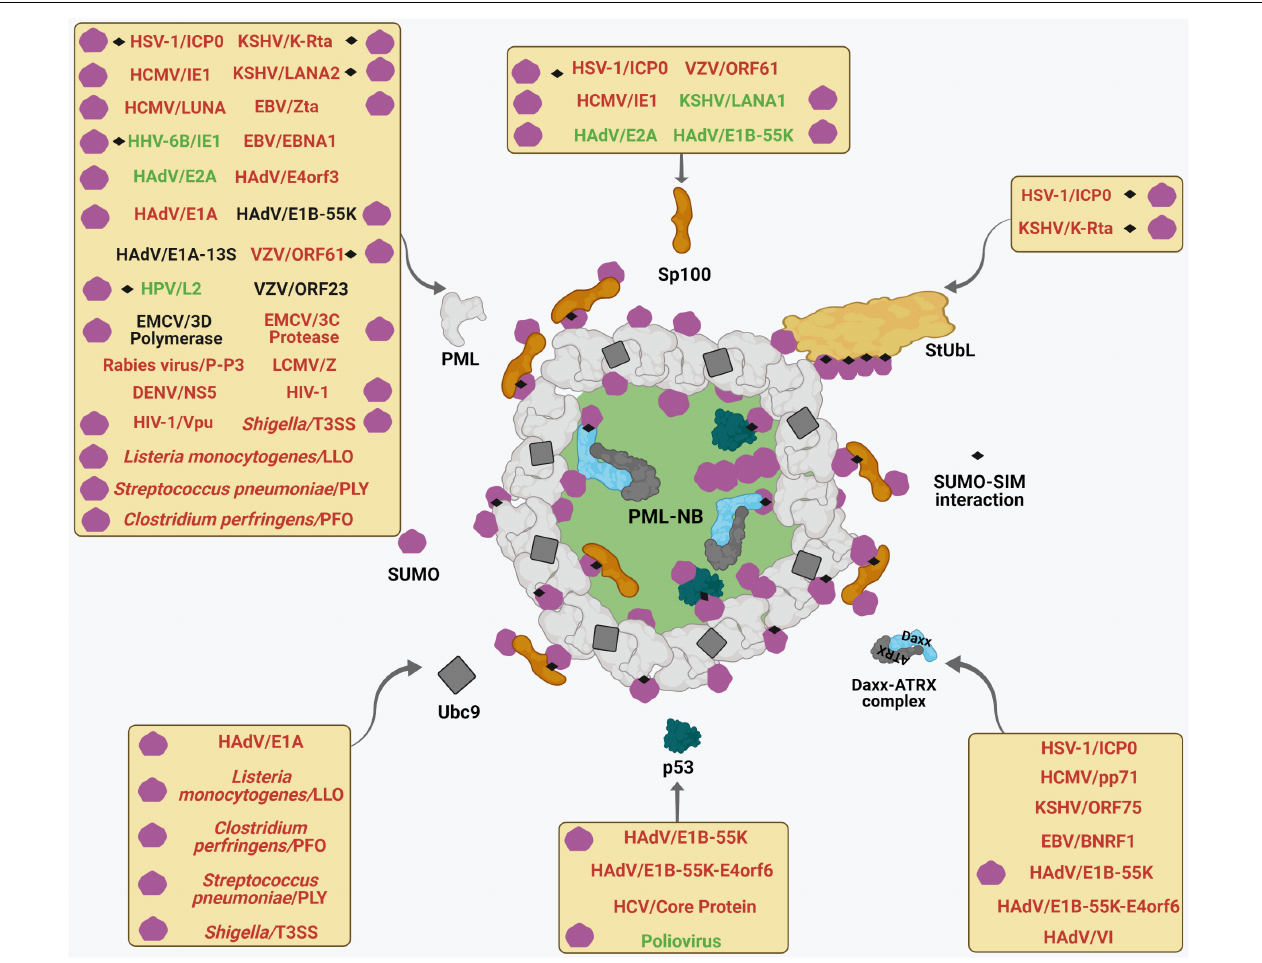
FIGURE 3 | Multifaceted interactions of viruses and bacteria with PML NBs. Different viruses and bacteria target mature PML NBs. Each box represents viral and bacterial components which target specific PML NB components (shown by curved arrows) to either foster (text-colored Green) or perturb (text-colored Red) PML NB integrity or are neutral (text colored Black) on PML NB. The pathogen-PML NB interactions which are SUMO-regulated and/or SUMO-SIM affinity driven are designated by using corresponding symbols within each box. For further details, please refer to the main body of the